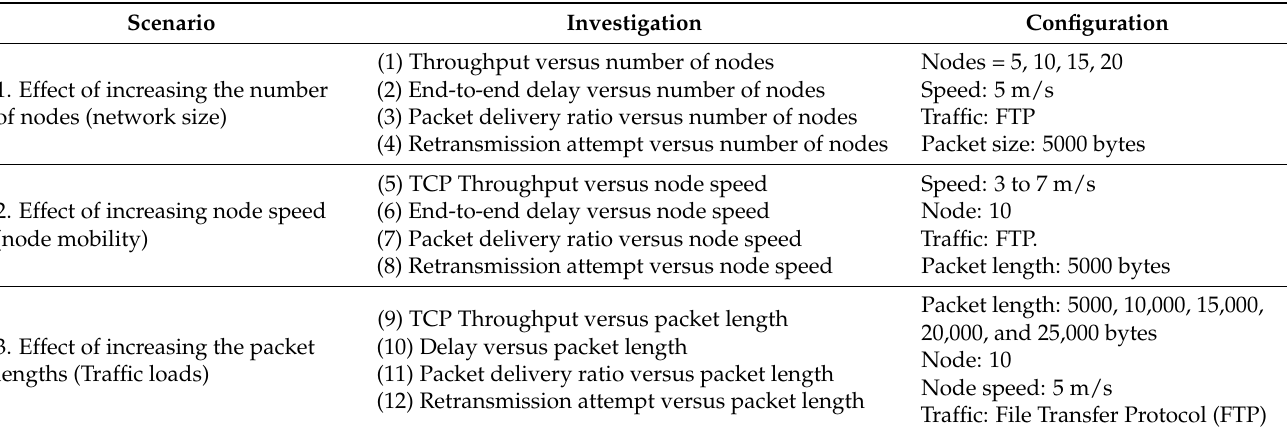
Table 5. Network scenarios and the corresponding investigation and